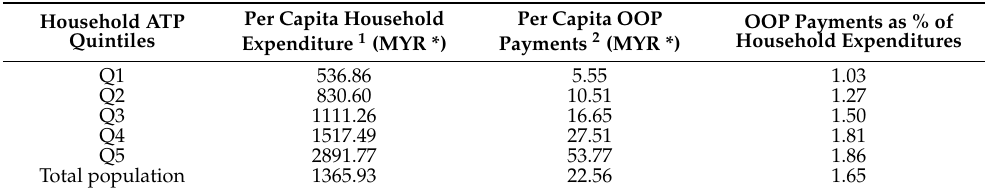
Table 1. Household expenditures and OOP payments for healthcare by household ATP quintiles, Malaysia 2014/2015.